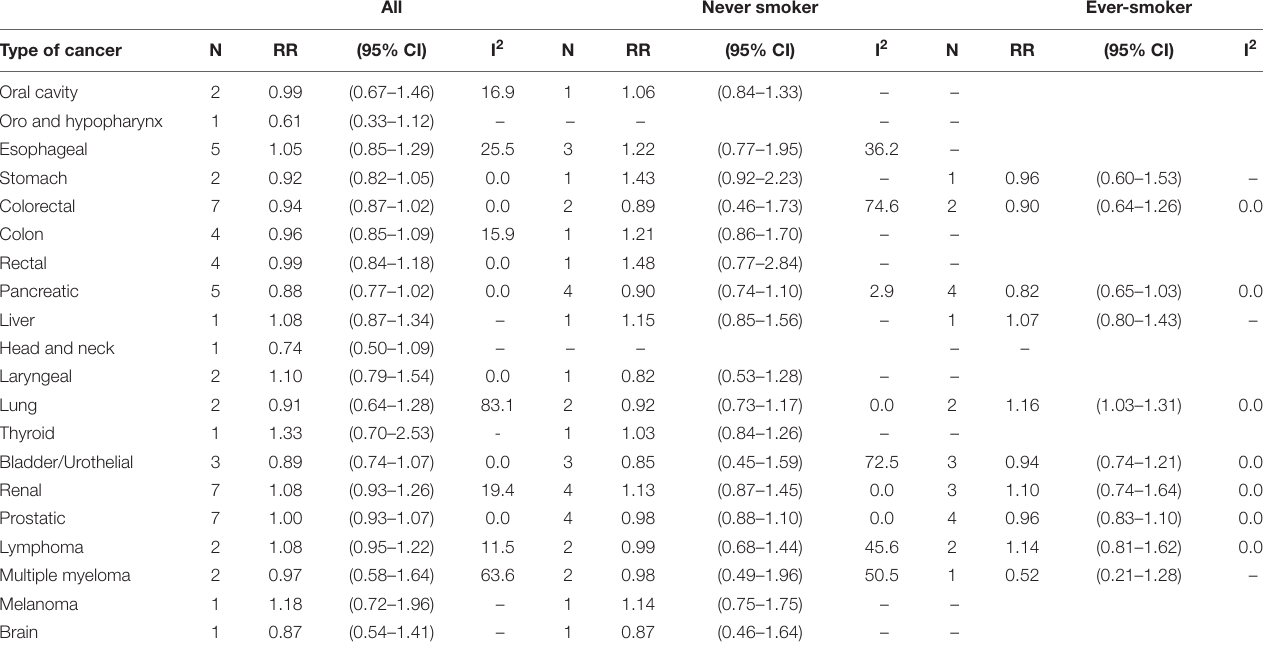
TABLE 2 | Summary relative risk (RR) with 95% confidence interval (CI) of the association between high dietary acrylamide exposure and site-specific cancer. All Never smoker